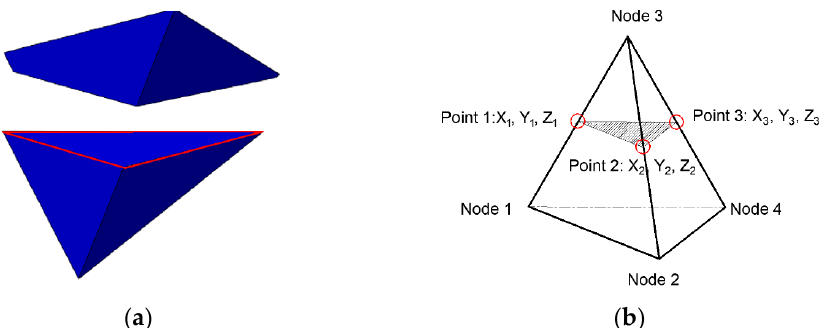
Figure 5. Crack portion of a triangular crack portion of a triangular crack: ( a ) fractured element; ( b ) intersection points.